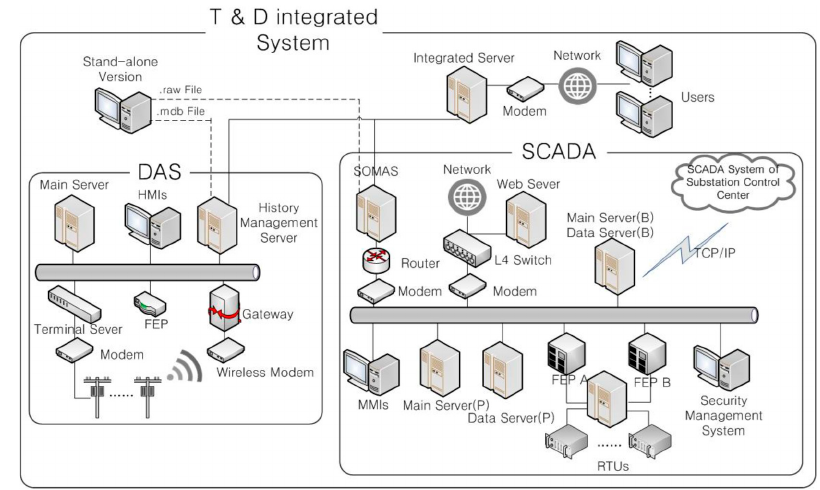
Figure 1. System diagram of transmission and distribution integrated system.